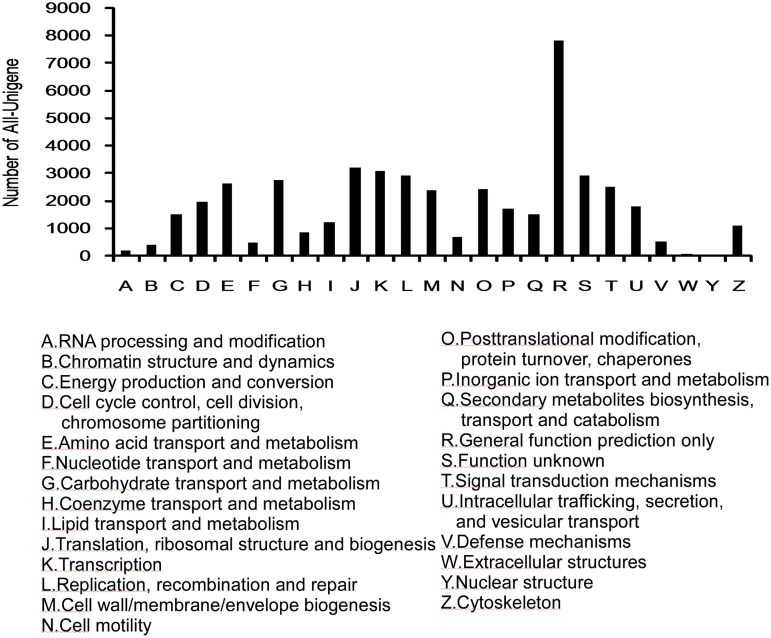
Clusters of orthologous groups annotated with COG terms.